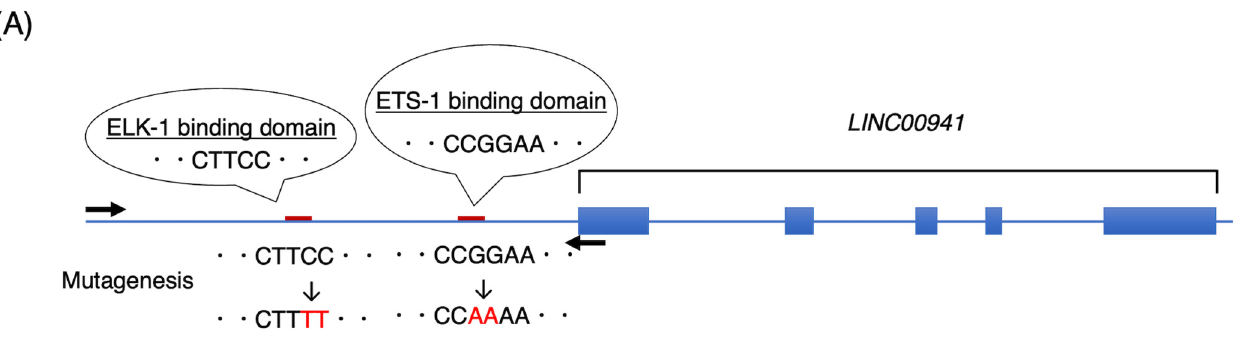
Figure 2. LINC00941 promoter activity is associated with MAPK activity. ( A ) A candidate promoter region of LINC00941 harboring consensus sequences of biding sites for ELK-1 and ETS-1. Arrows indicate relative positions of primers spanning the 3720-bp genomic region immediately upstream of exon 1 of LINC00941 used for construction of reporter vectors for the promoter assay. Mutagenic disruptions of the consensus binding sites used in experiments shown in ( C ) are indicated. ( B ) Re- porter assays with modulation of MAPK activity. Left panel: the candidate promoter region reveals the promoter activity significantly associated with MAPK activity modulated by the active MEK/MAP2K transfection or FBS starvation in AsPC-1 (* p < 0.05). Right panel: Immunoblots show- ing upregulation and downregulation of MAPK activity in AsPC-1 by the active MEK transfection and FBS starvation, respectively. ( C ) Mutagenesis of the consensus binding sites in the promoter of LINC00941 results in a significant reduction of promoter activity by disruption of the binding site of ETS-1, and not that of ELK-1, in both active MEK transfection and FBS starvation in AsPC-1 (* p < 0.05). E+E means disruption of both binding sites of ETS-1 and ELK-1. 3.4. Effect of LINC00941 on Cell Proliferation